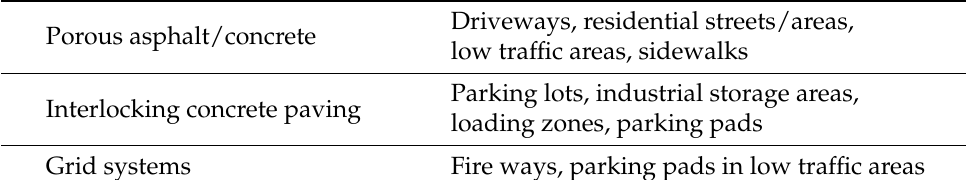
Table 2. Different types of permeable